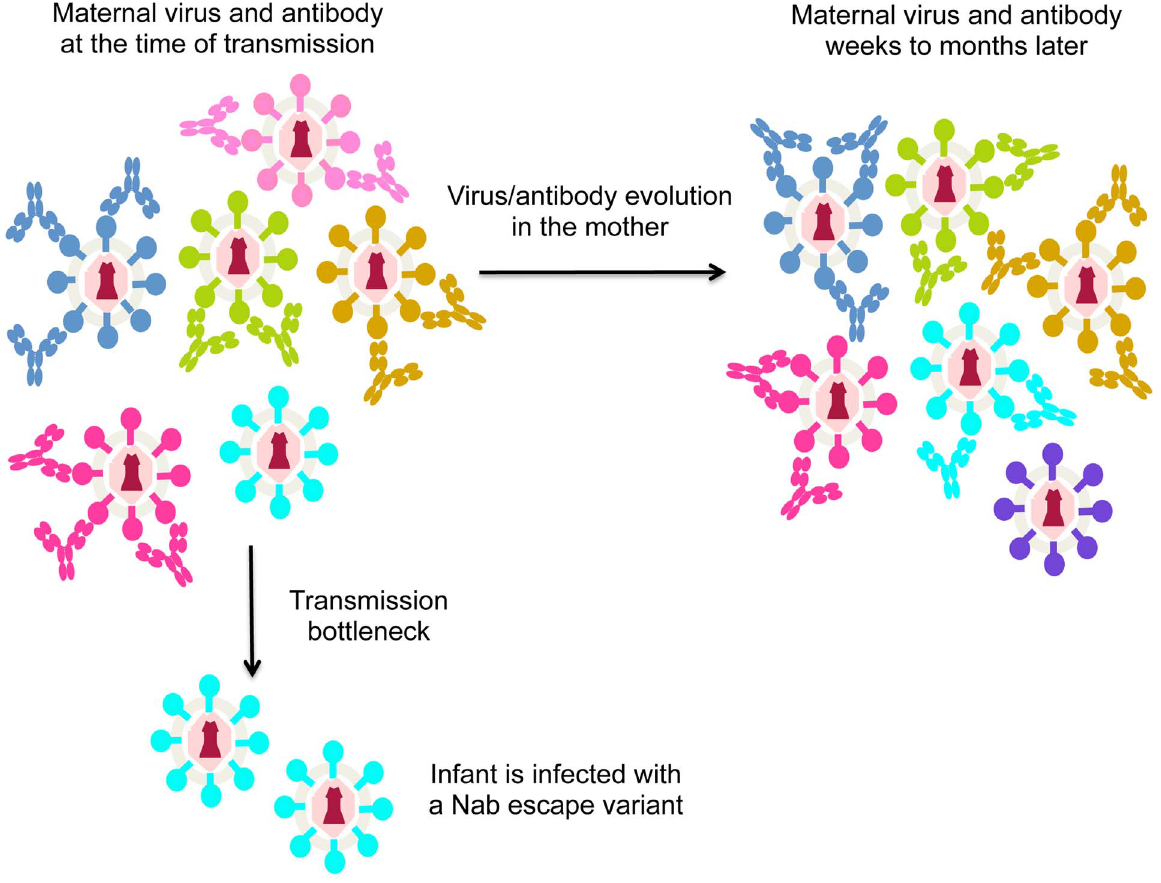
Figure 1. Schematic of virus escape from antibody in MTCT. Different virus variants are shown in different colors, with the antibodies that recognize and neutralize them shown in the same color. For simplicity, in this figure each antibody only recognizes one virus variant, although in reality, some will recognize several different variants. During the process of transmission (transmission bottleneck) the infant is infected with a viral variant from the mother that was not neutralized by her antibodies. The arrow indicating evolution in the mother shows how virus/antibody dynamics change. In particular, the virus that was not recognized by maternal antibodies at the time of transmission (shown in cyan) may be recognized by newly elicited antibodies present a few weeks later. At that time, a different escape variant (shown in purple) may have